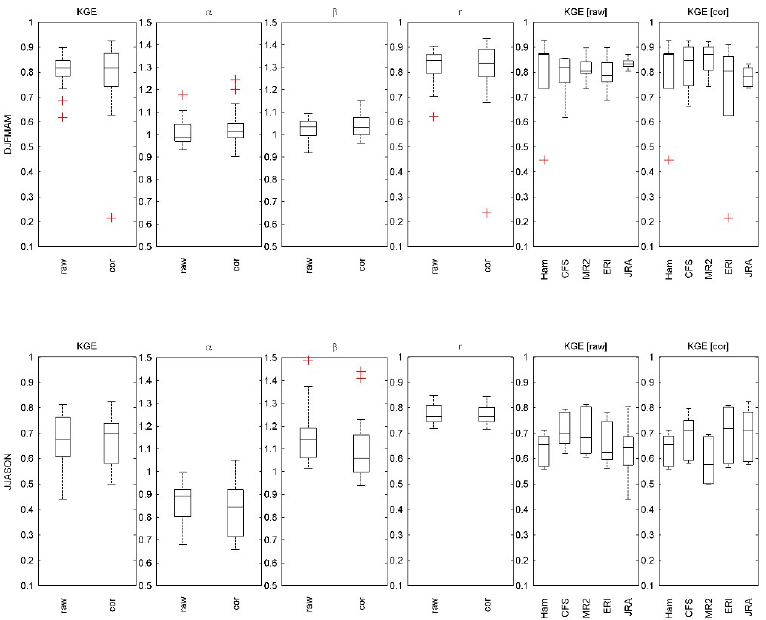
Figure 4. Hydrologic performance of the Penman-Montheith formulation forced with raw and corrected HRW fields. These latter are taken from reanalyses CFSR, MERRA-2, ERA-Interim, JRA-55 at sites Q1 to Q6 ( n = 24). Performance is assessed through KGE and α , β , r components evaluated from December to May (DJFMAM) and from June to November (JJASON). KGE values are ventilated for each reanalysis and compared to the Hamon temperature-based ET 0 formulation ( n = 6).